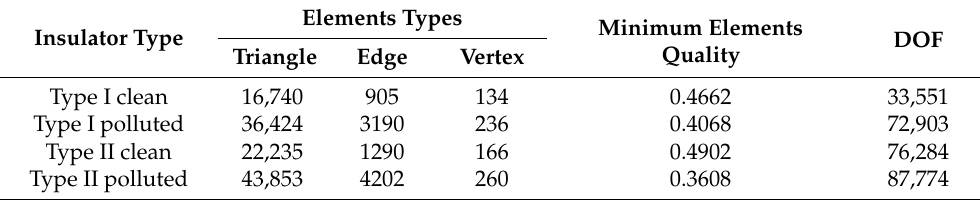
Table A1. Simulation parameters of insulators